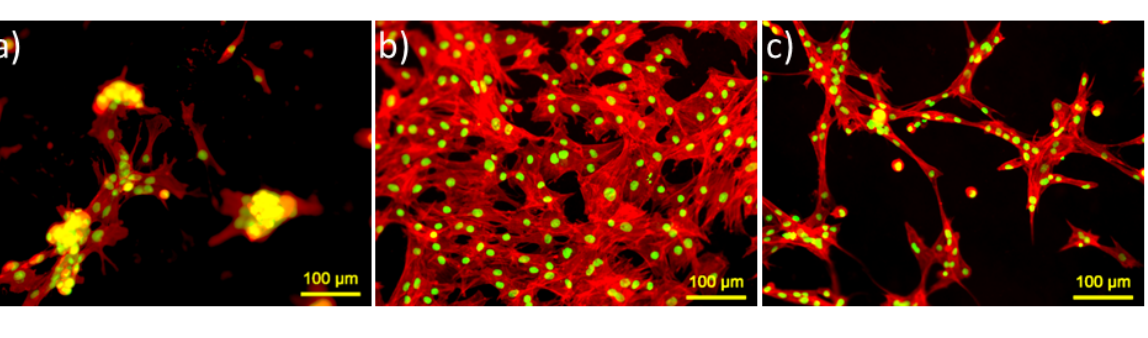
Figure 3. FM images of MSCs adhered on ( a ) alginate; ( b ) ADA-GEL; and ( c ) ADA-GEL-nBG hydrogel films after 48 h of cultivation. The cells were stained for actin (red) and nucleus (green).